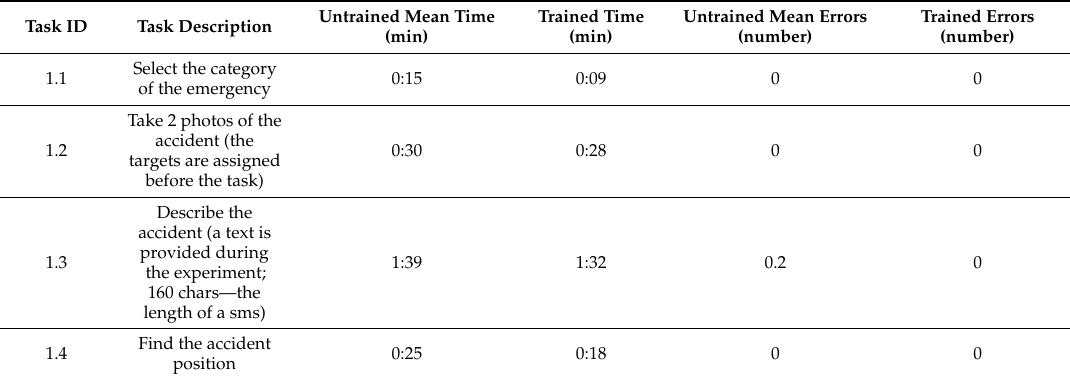
Table 2. Subtasks of the usability